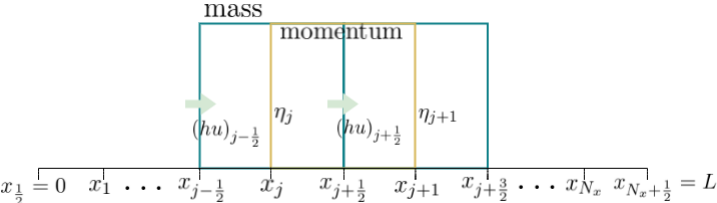
Figure 6. Illustration of the finite volume method on a staggered